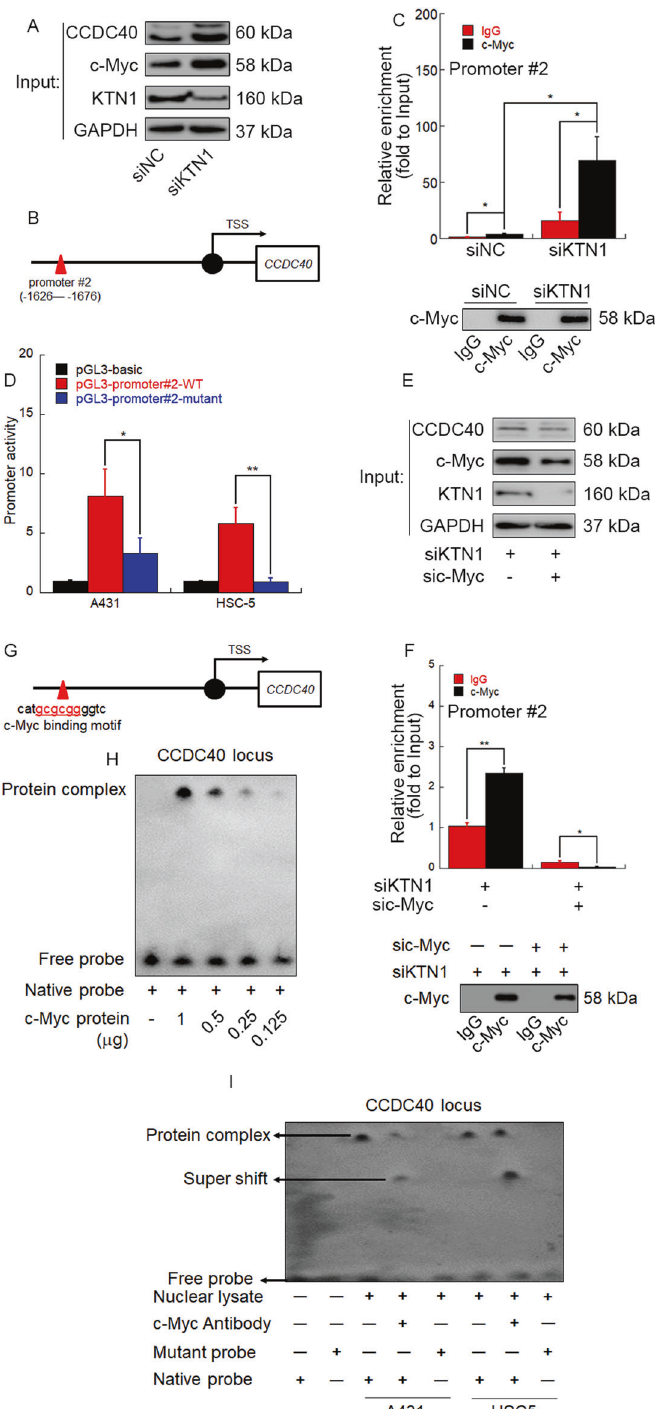
Fig. 5 c-MYC is upregulated by KTN1 knockdown and directly binds to the promoter region to transactivate CCDC40. A Schematic diagram for the positions of two predicted promoters in the CCDC40 gene. B , C A431 cells were transfected with siKTN1. Total cell lysates were subjected to ChIP-qPCR assay and immunoblotting. TSS: transcription start site. qPCR results represent the means ± SD. Representative of results from three biological replicates. D Luciferase reporter assay of the predicted promoter #2. Data represent the means ± SD. Representative of results from three biological replicates. E , F A431 cells were transfected with siKTN1 or co-transfected with siKTN1 and sic- Myc. Total cell lysates were subjected to ChIP-qPCR assay and immunoblotting. qPCR results represent the means ± SD. Representative of results from three biological replicates. G Schematic diagram for the predicted interaction site (red underlined bases) of c-Myc (c-Myc binding motif) in CCDC 40 promoter #2. H Electrophoretic mobility shift assay (EMSA) to detect the direct interaction between the c-Myc binding motif and puri fi ed c-MYC protein. Representative of results from three biological replicates. I Nuclear lysates from A431 and HSC-5 cells were subjected to EMSA to detect the direct interaction between the c-Myc binding motif and nuclear protein. Anti-c-Myc antibody was added for supershift of the binding complex. Representative of results from three biological